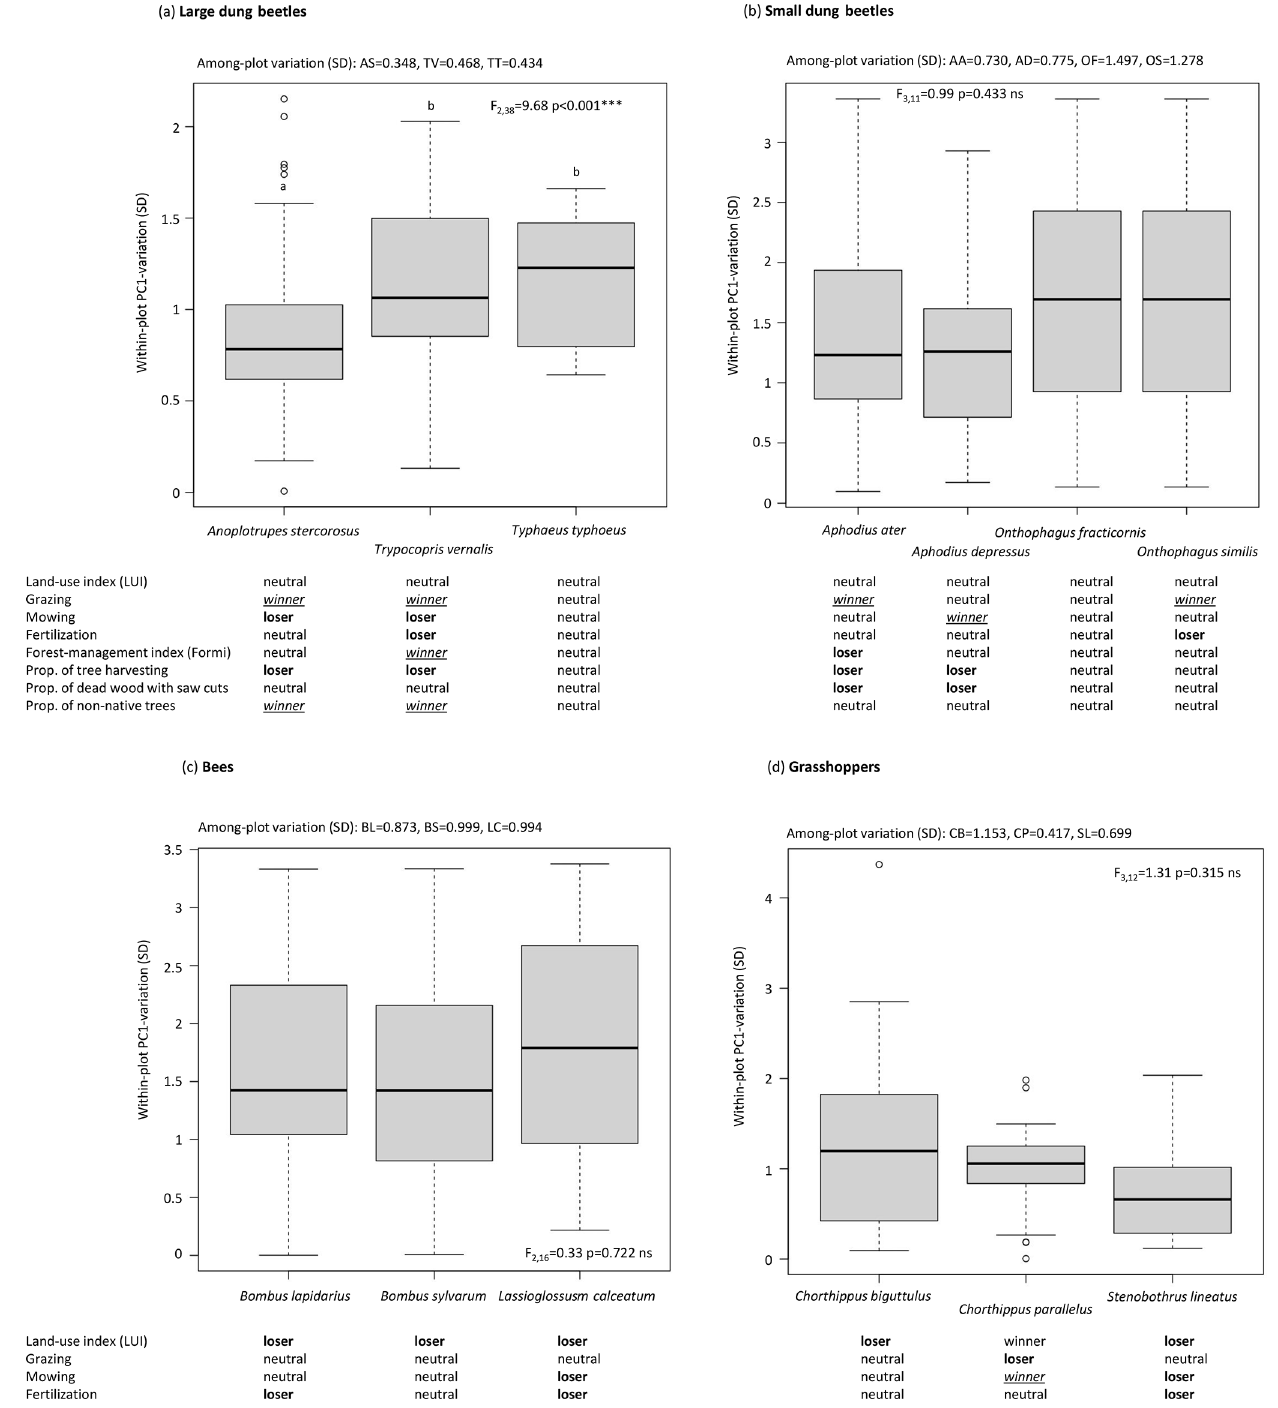
Figure 2. Differences in within-plot variation of relative morphological traits by the principal component (PC1) scores in (a) large dung beetles, (b) small dung beetles, (c) bees, and (d) grasshoppers. Among-plot variation is shown above the plots, the species’ status to the respective land-use component underneath. Abbreviations: SD – standard deviation, ns – not significant ( p > 0.05), ∗∗∗ = p ≤